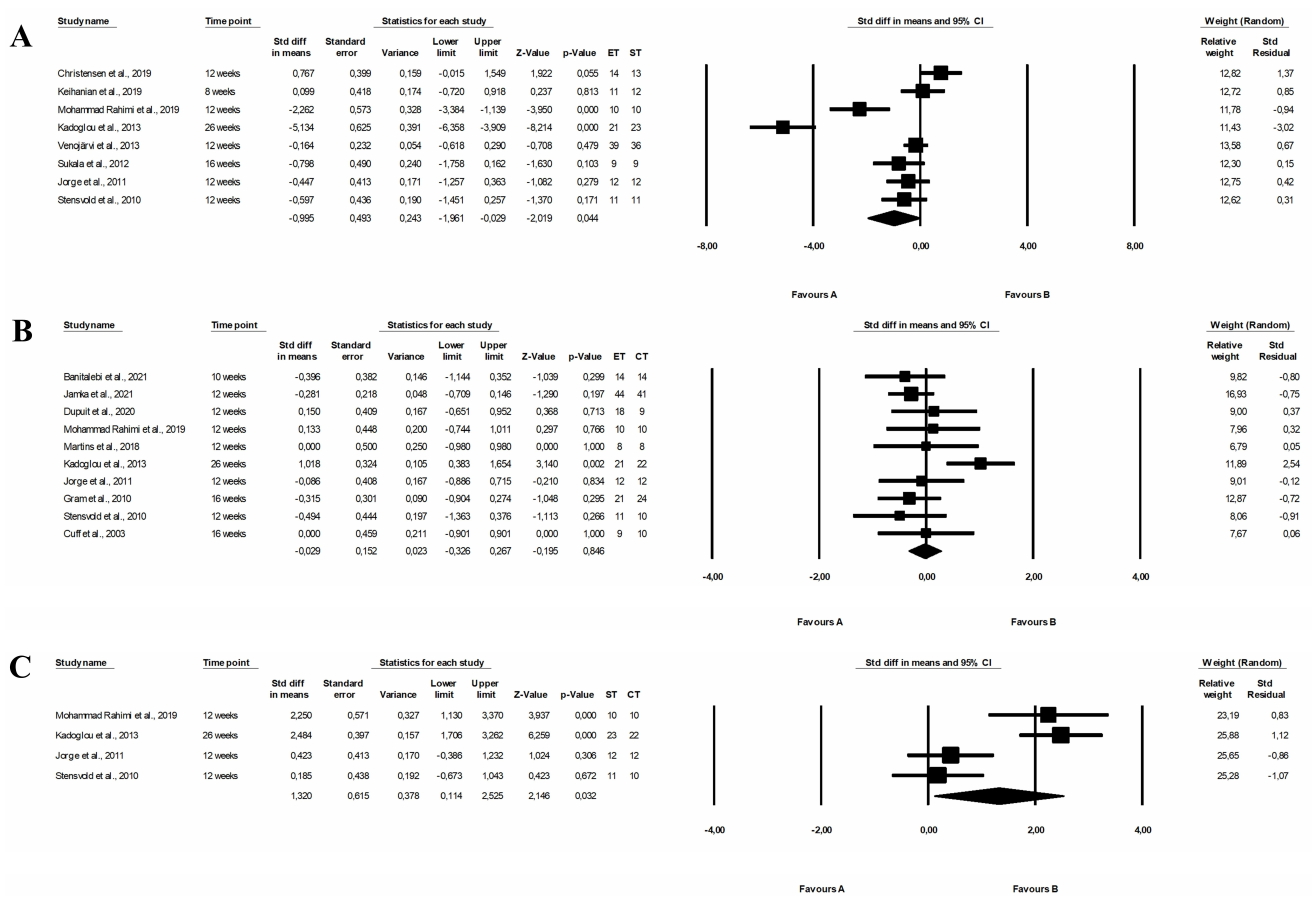
Figure 4. Forest plots of the effect of training programmes on glycated haemoglobin levels: ( A ) endurance (favours A) vs. strength (favours B) training (random model) [22,44–46,63,65,68,69]; ( B ) endurance (favours A) vs. endurance-strength (favours B) training (random model) [22,37– 39,46,48,63,69,70,74]; ( C ) strength (favours A) vs. endurance-strength (favours B) training (random model) [22,46,63,69]. CI—confidence interval; CT—combined training; ET—endurance training; ST—strength training; Std—standard; Std diff—standard